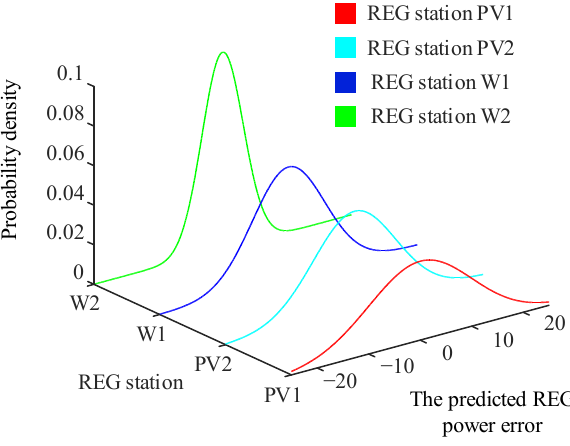
Figure 6. Probability density function of the predicted REG power error. According to the predicted output of each REG station and its probability density function, the output realization probability of each REG station can be obtained, as shown in Figure 7.